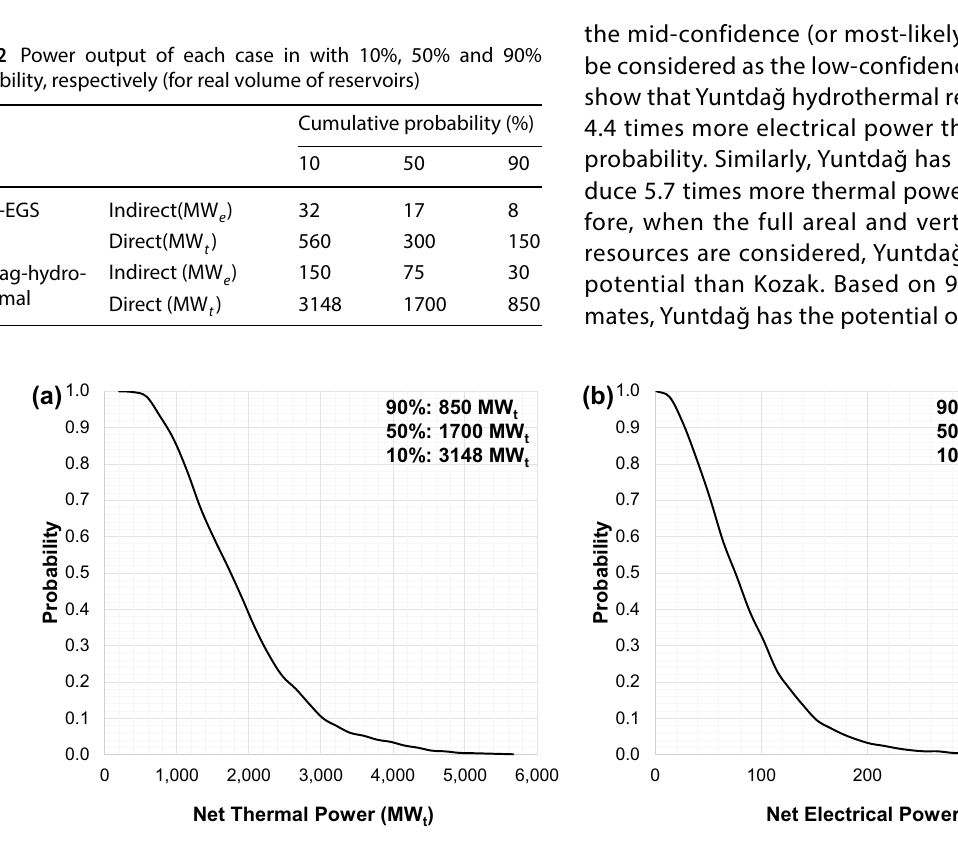
Fig. 7 Cumulative expectation curve for Yuntdağ hydrothermal reservoir for real-volume case a direct utilization, b indirect